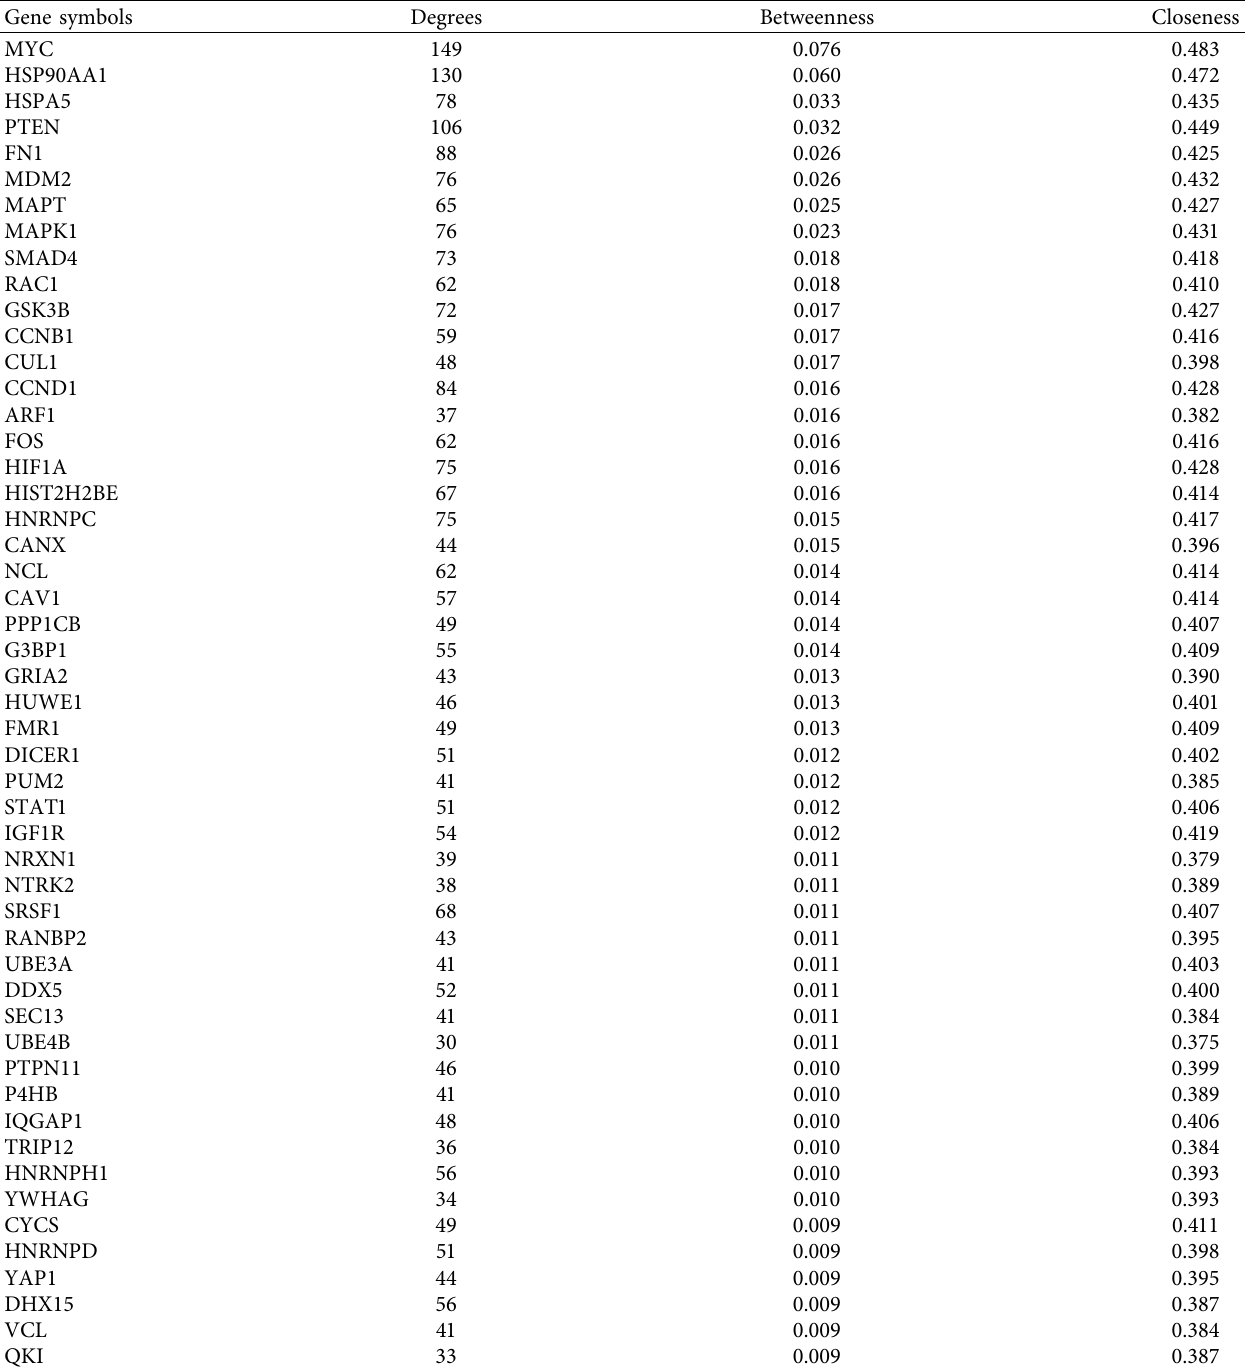
Table 2: A total of 96 nodes demonstrated high centrality values in the PPI network associated with OTSCC and BSCC and considered hub